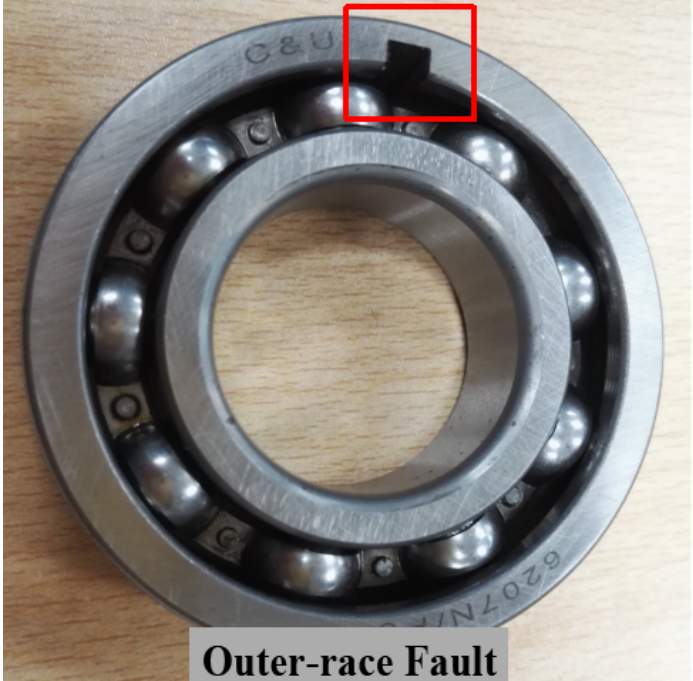
Figure 4. Test bearing with the outer raceway